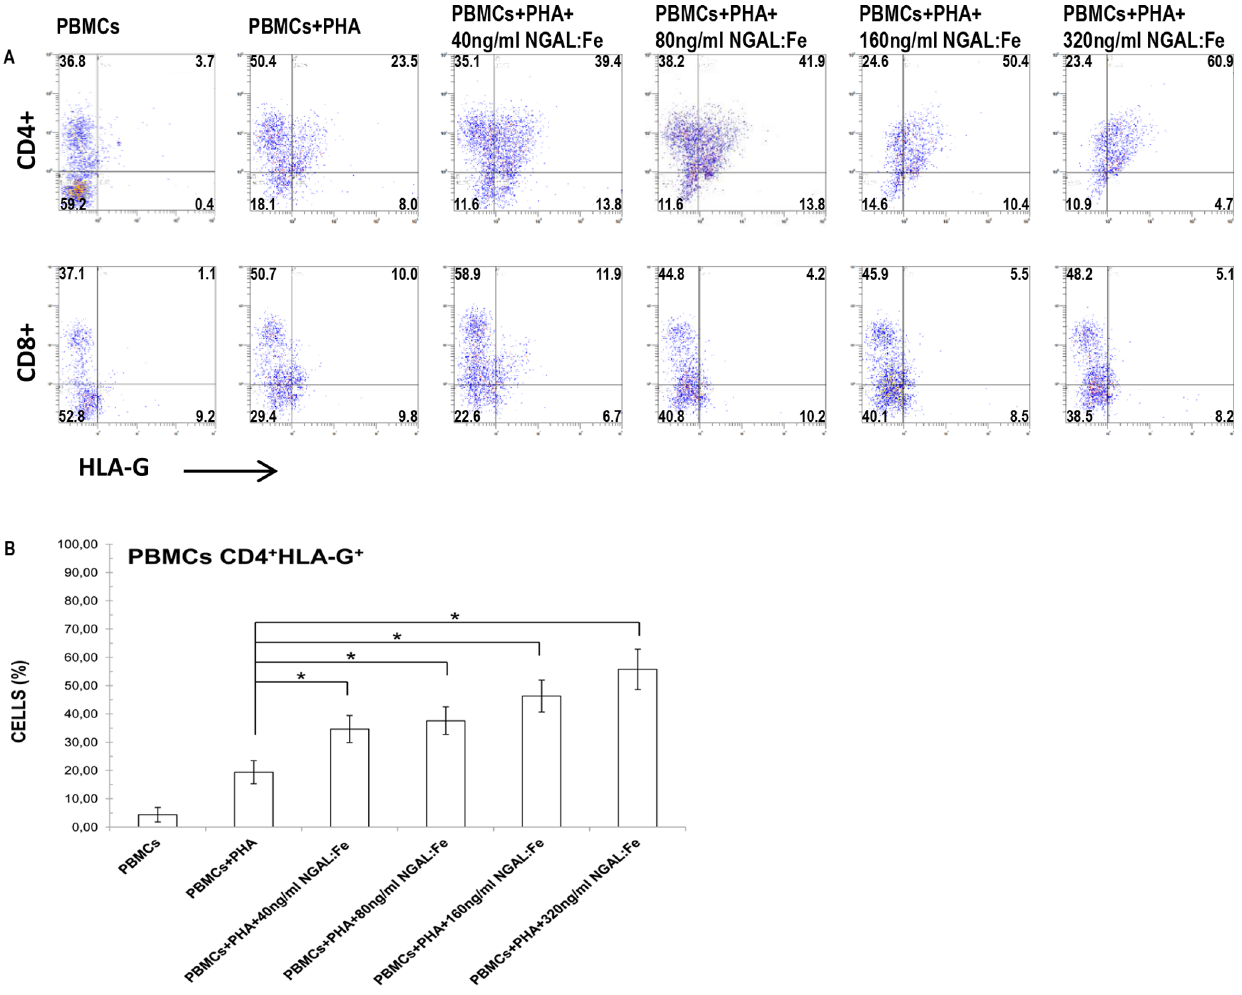
Figure 1. Effect of NGAL on HLA-G expression in PHA-activated PBMCs. A) Flow cytometry analysis of surface HLA-G on CD4 + and CD8 + cells. PBMCs were treated with increasing concentrations of NGAL:Enterobactin:Iron (40 ng/ml, 80 ng/ml, 160 ng/ml, and 320 ng/ml). A dose- dependent rise in the percentage of CD4 + HLA-G + cells was evident. The percentage of CD8 + HLA-G + cells did not show any marked changes. Data are representative of 8 independent experiments. The number in each quadrant represents the percentage of the total population. B) Data are expressed as percentages of CD4 + HLA-G + cells. Means 6 SD; n=8. * p , 0.05.